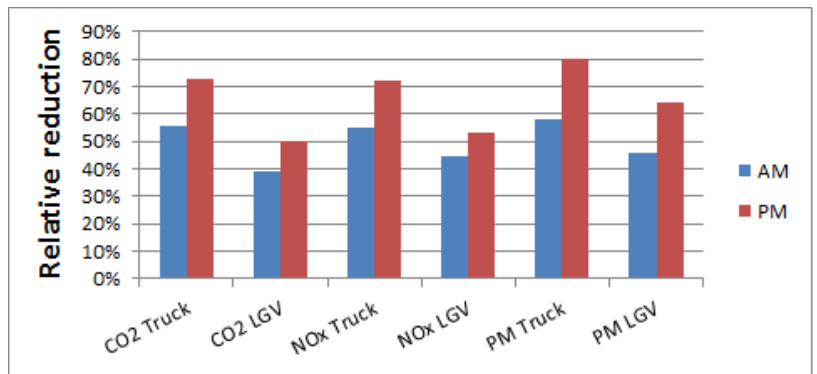
Figure 9. Relative reduction on emissions for scenario 1